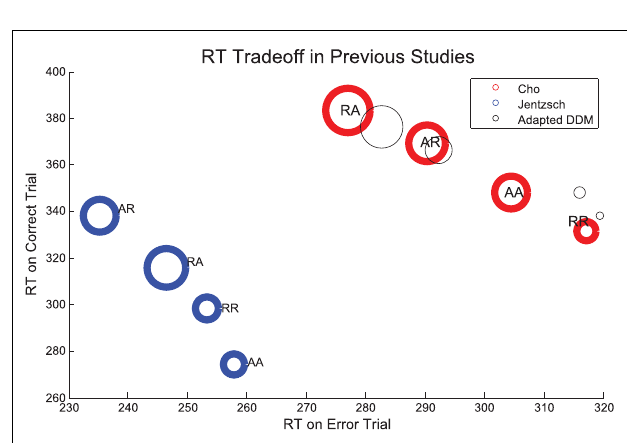
FIGURE 4 | Sequential RT tradeoff for unbiased tasks: a slower RT for correct trials corresponds to a faster RT for error trials for the sequences RR,AR, RA, andAA. The RT tradeoff for Experiment 1 is shown in red. Also shown, in blue: the RT tradeoff from a prior study by Jentzsch and Sommer (2002). Adapted DDM fits to Experiment 1 data are shown in black.The areas of the circles are proportional to the